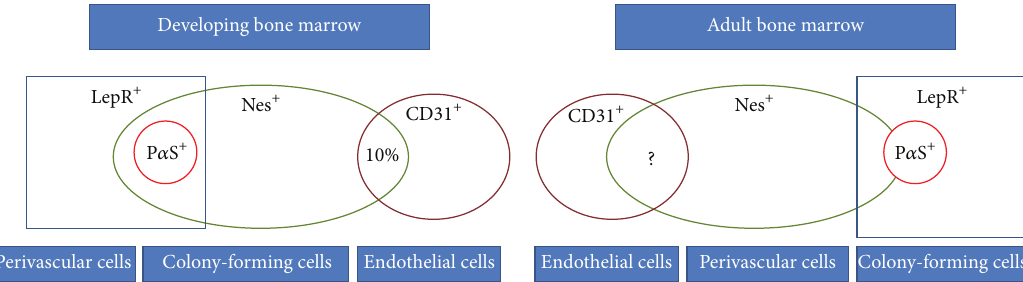
Figure 1: Representation of Nes + cells in different developmental phases. Nes + cells may represent different cell population at developmental and adult stages. Nes + cells contain both endothelial and nonendothelial cells in developing bone marrow and nonendothelial Nes + cells participate in endochondral ossification as MSCs. In adult bone marrow, a small portion of Nes + cells overlap with LepR + cells which contain most CFU-F cells while most Nes + cells are vascular cells to help build blood vessel walls and maintain the niche for HSCs. The relationship between Nes + cells and endothelial cells in adult is still